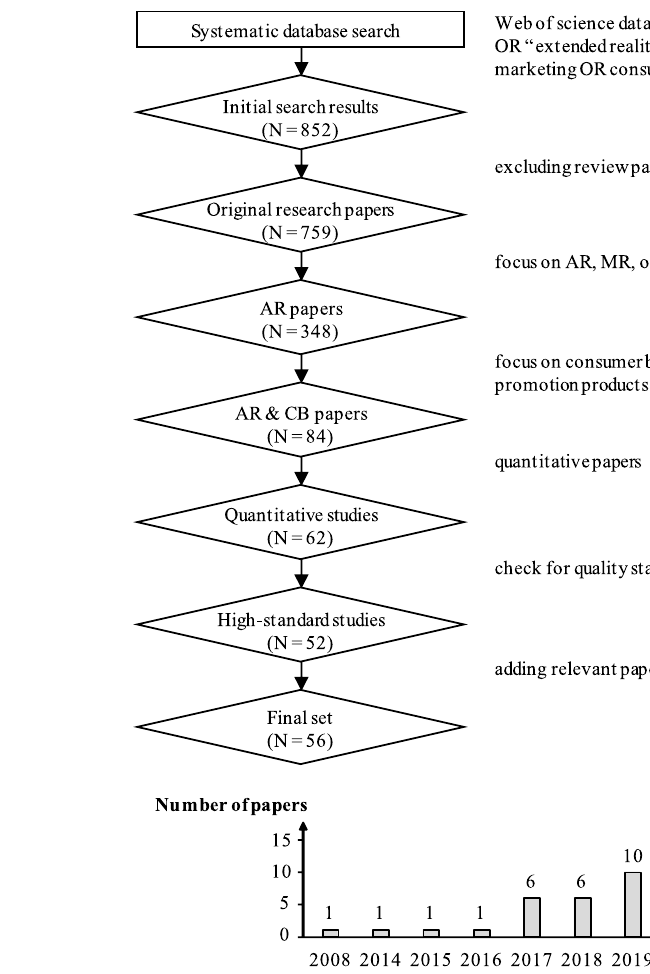
FIGURE A1 Literature search process and papers per